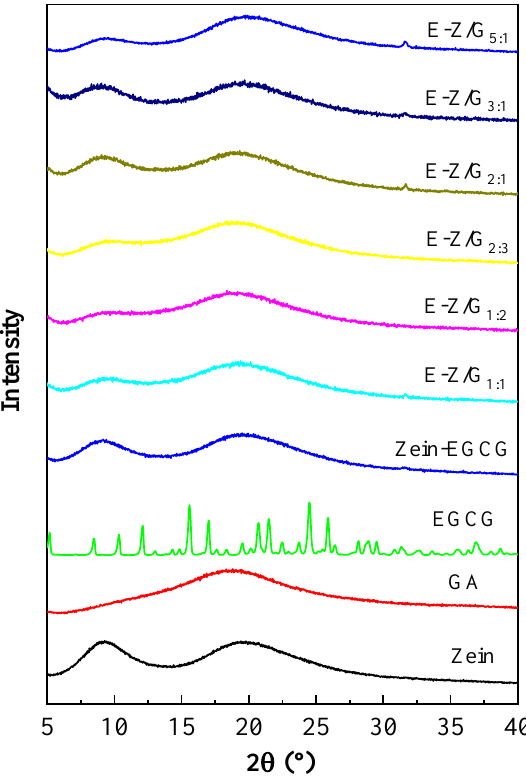
Figure 5. The XRD analysis of different samples.